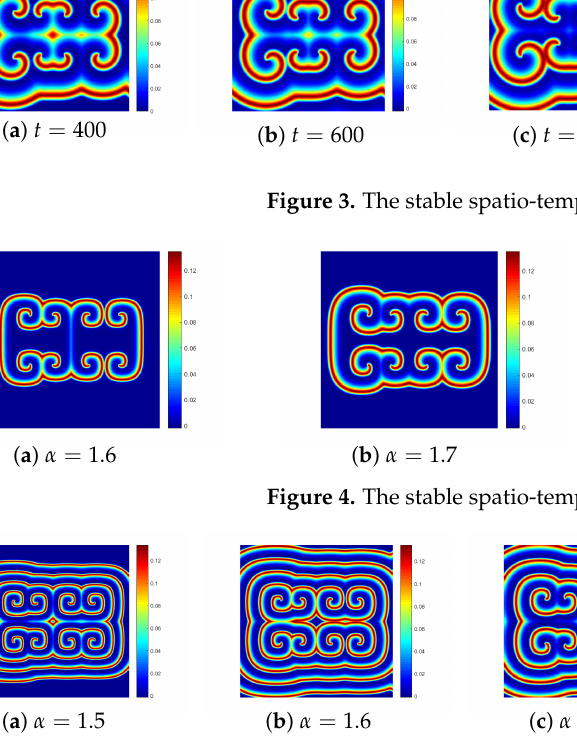
Figure 5. The stable spatio-temporal waves of v at t = 1000 and different α for Experiment